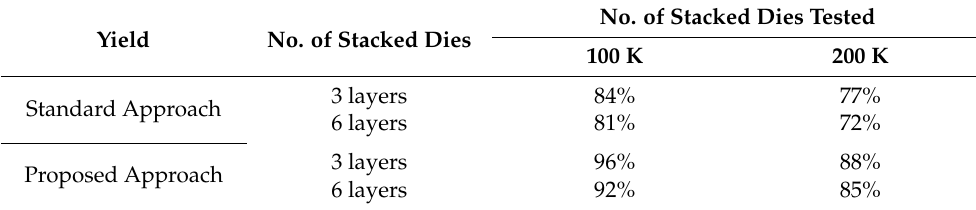
Figure 13. Yield analysis graph between conventional and proposed TSV BIST approach (Reprinted with permission from ref. [21]. Copyright 2022 Springer Nature). Table 2. Yield numbers in standard and proposed TSV BIST Repair